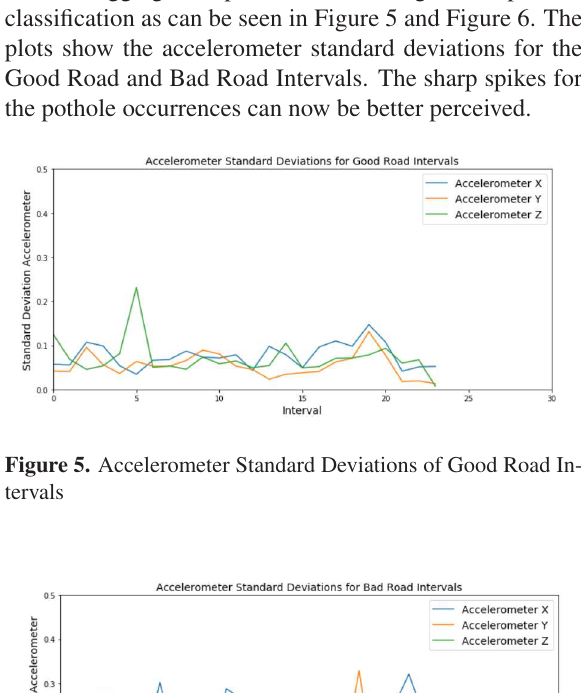
Figure 2. Raw Data Collection